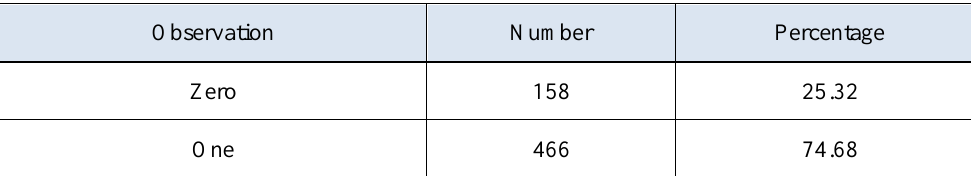
Table 2. short-term credit constraints observations